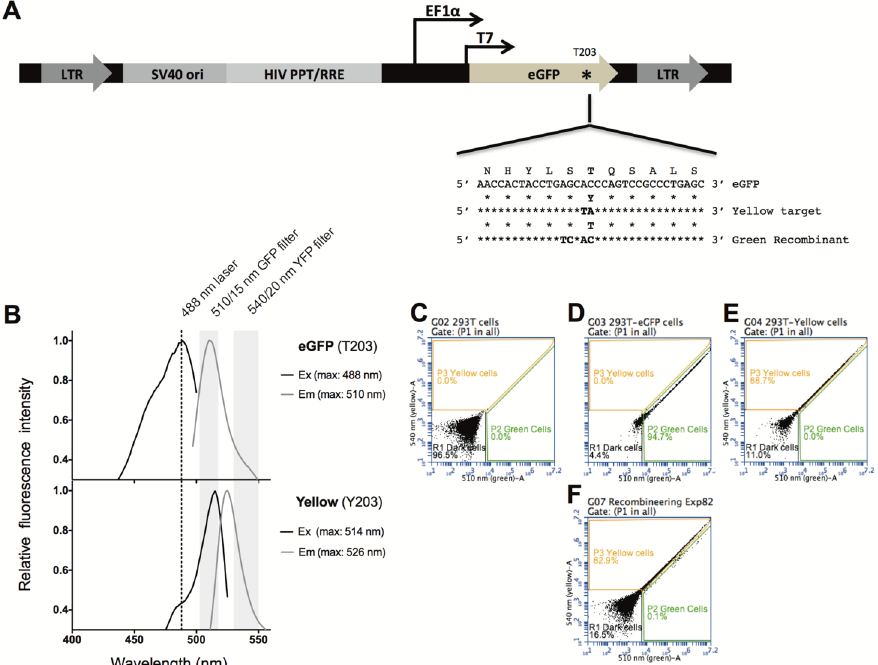
Fig 2. Fluorescent recombineering reporter. A) Lentiviral vector pDual-eGFP Y203 was used to deliver a Yellow florescent protein variant of eGFP to serve as the recombineering target transgene. B) Fluorescence excitation and emission spectra of purified eGFP and eGFP Y203 proteins. C-F) Flow cytometry was used to quantify 293T-Green recombinant and 293T-Yellow parental phenotypes. C) Untransduced cells were quantified in the R1 gate, D) pDual- eGFP transduced Green cells were quantified in the P2 gate and E) pDual-eGFP Y203 transduced Yellow cells were quantified in the P3 gate. F) Example results from one recombination experiment using Yellow cells as a target and an oligo that codes for Green